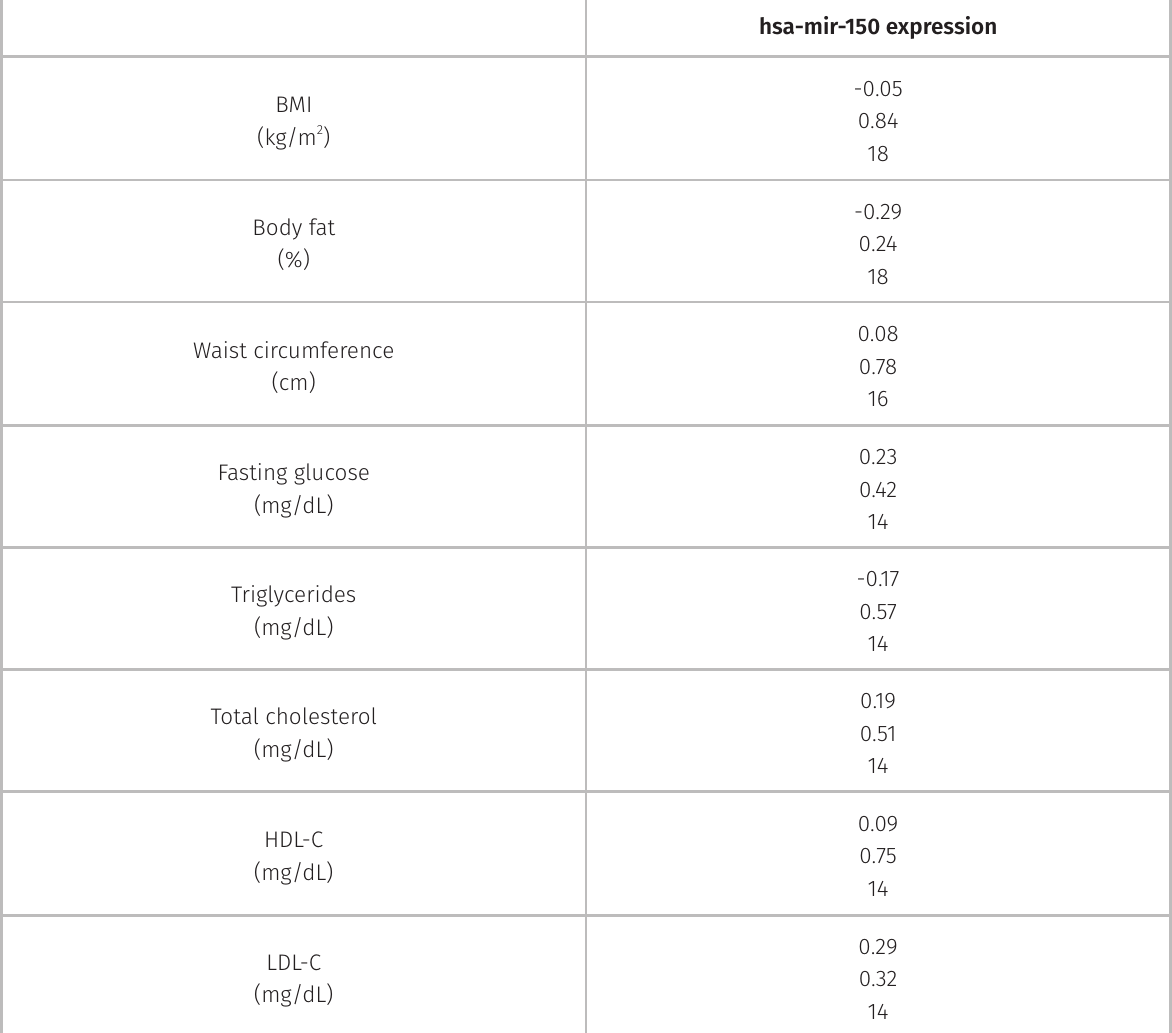
Table III. Pearson’s correlation between hsa-mir-150-5p expression and obesity, glycemia, and lipid